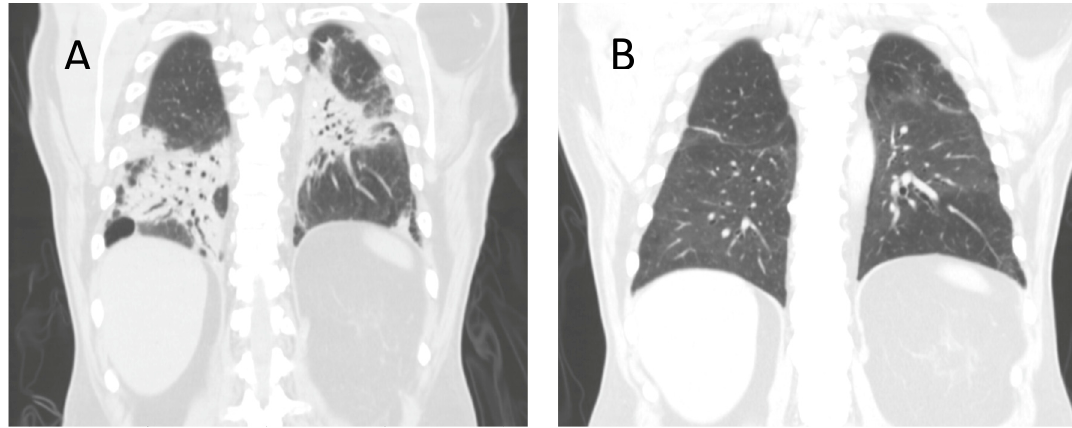
Figure 1. ( A ) CT Chest on admission showing significant multifocal airspace consolidation in mid-to-lower lung zones. ( B ) Repeat CT Chest after completion of steroid course, showing improved bibasilar consolidation.